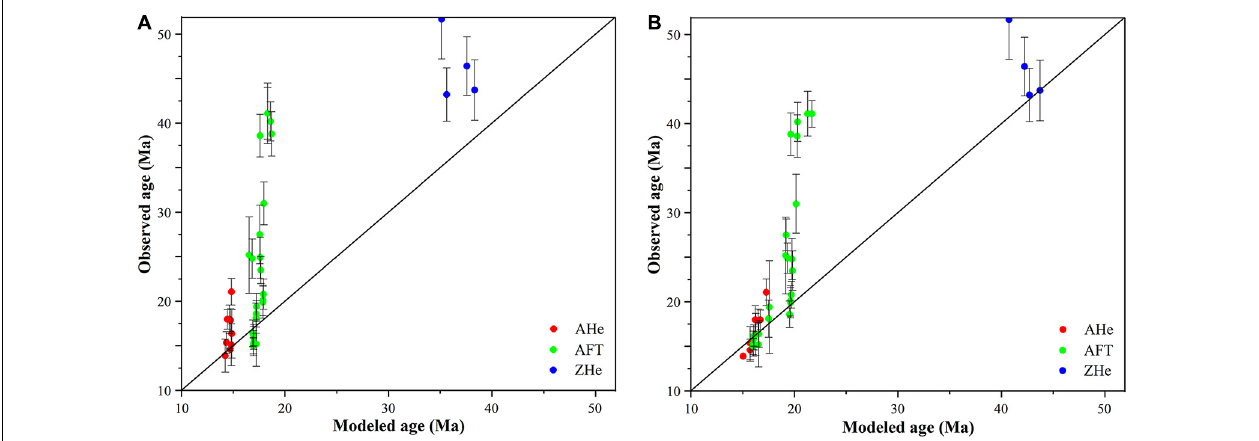
FIGURE 5 | Comparison of observed and predicted thermochronological data for the best-fit parameters. (A) Comparison of observed and predicted thermochronological data under the “denudation scenario” with four-stage denudation. (B) Comparison of observed and predicted thermochronological data under the “relief scenario.”